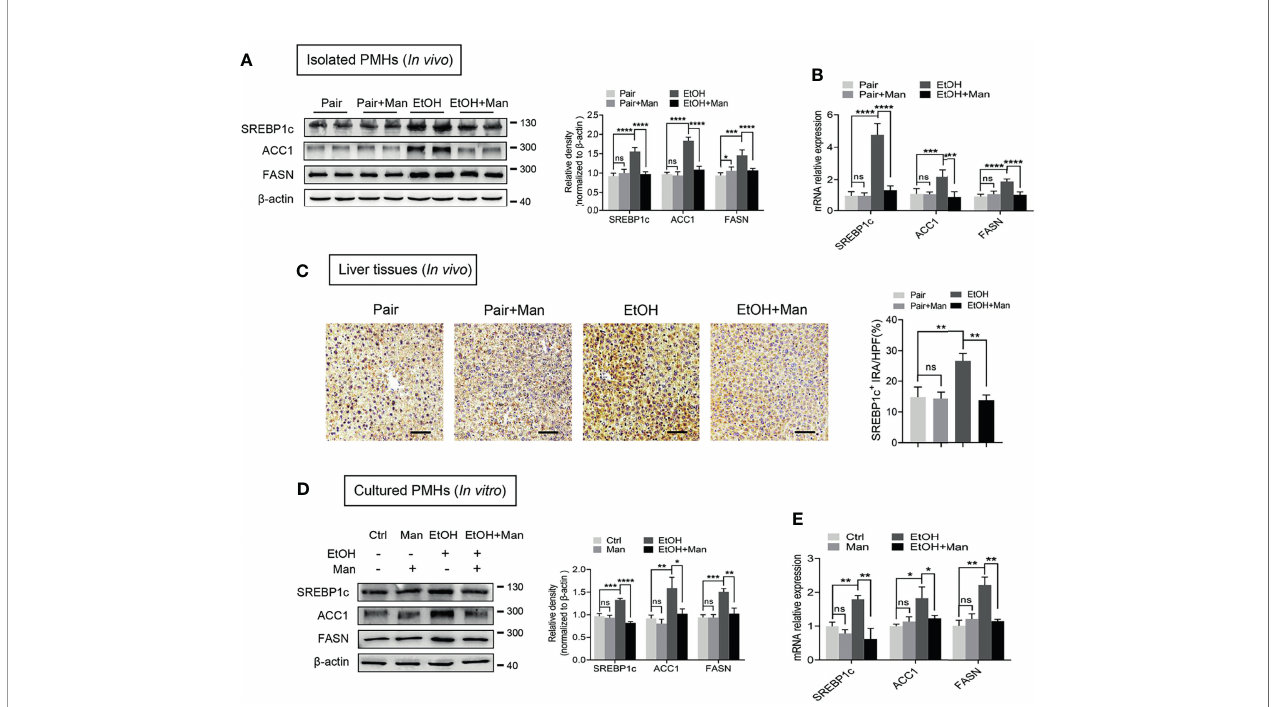
FIGURE 4 | Mannose inhibits ethanol-induced hepatocyte lipogenesis. (A-C) Isolated PMHs were obtained from mice fed the control diet (Pair) or ethanol diet (EtOH) supplemented with or without 3% (w/v) mannose (Man). The protein (A) and mRNA (B) levels of SREBP1c, ACC1 and FASN were evaluated (n = 6). (C) Representative images of SREBP1c staining on the liver sections (n = 3). Scale bars = 100 m m. (D, E) PMHs from WT mice were stimulated by 200 mM ethanol (EtOH) with/without 5 mM mannose (Man) for 24 h, PMHs with cell culture medium as control (Ctrl). The protein (D) and mRNA (E) levels of lipogenic enzyme genes SREBP1c, ACC1, and FASN were evaluated (n = 3). Data are expressed as the means ± SEM of three independent experiments. * p < 0.05, ** p < 0.01, *** p < 0.001, **** p < 0.0001, ns, not signi fi cant, unpaired two-tailed t